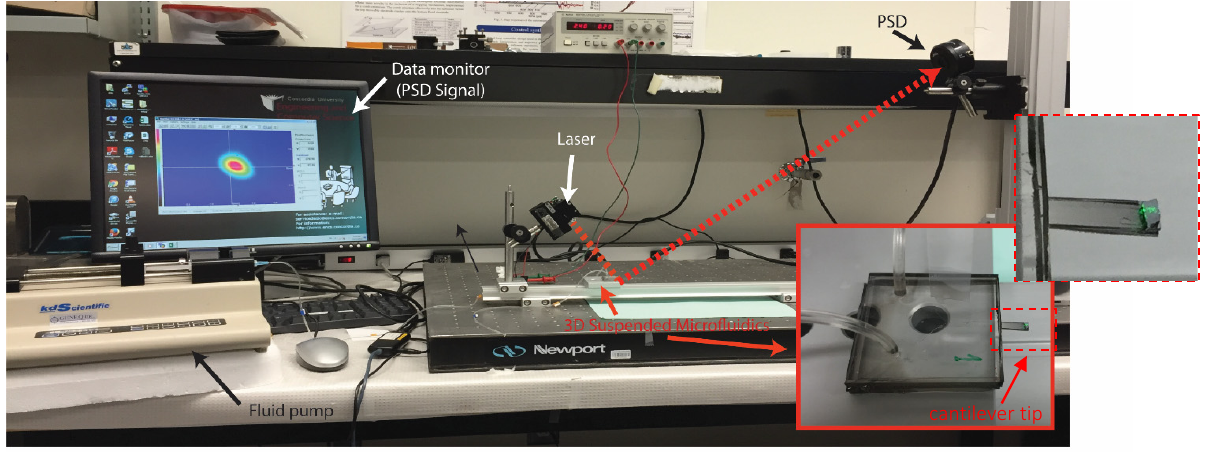
Figure 11. Laser displacement measurement system.